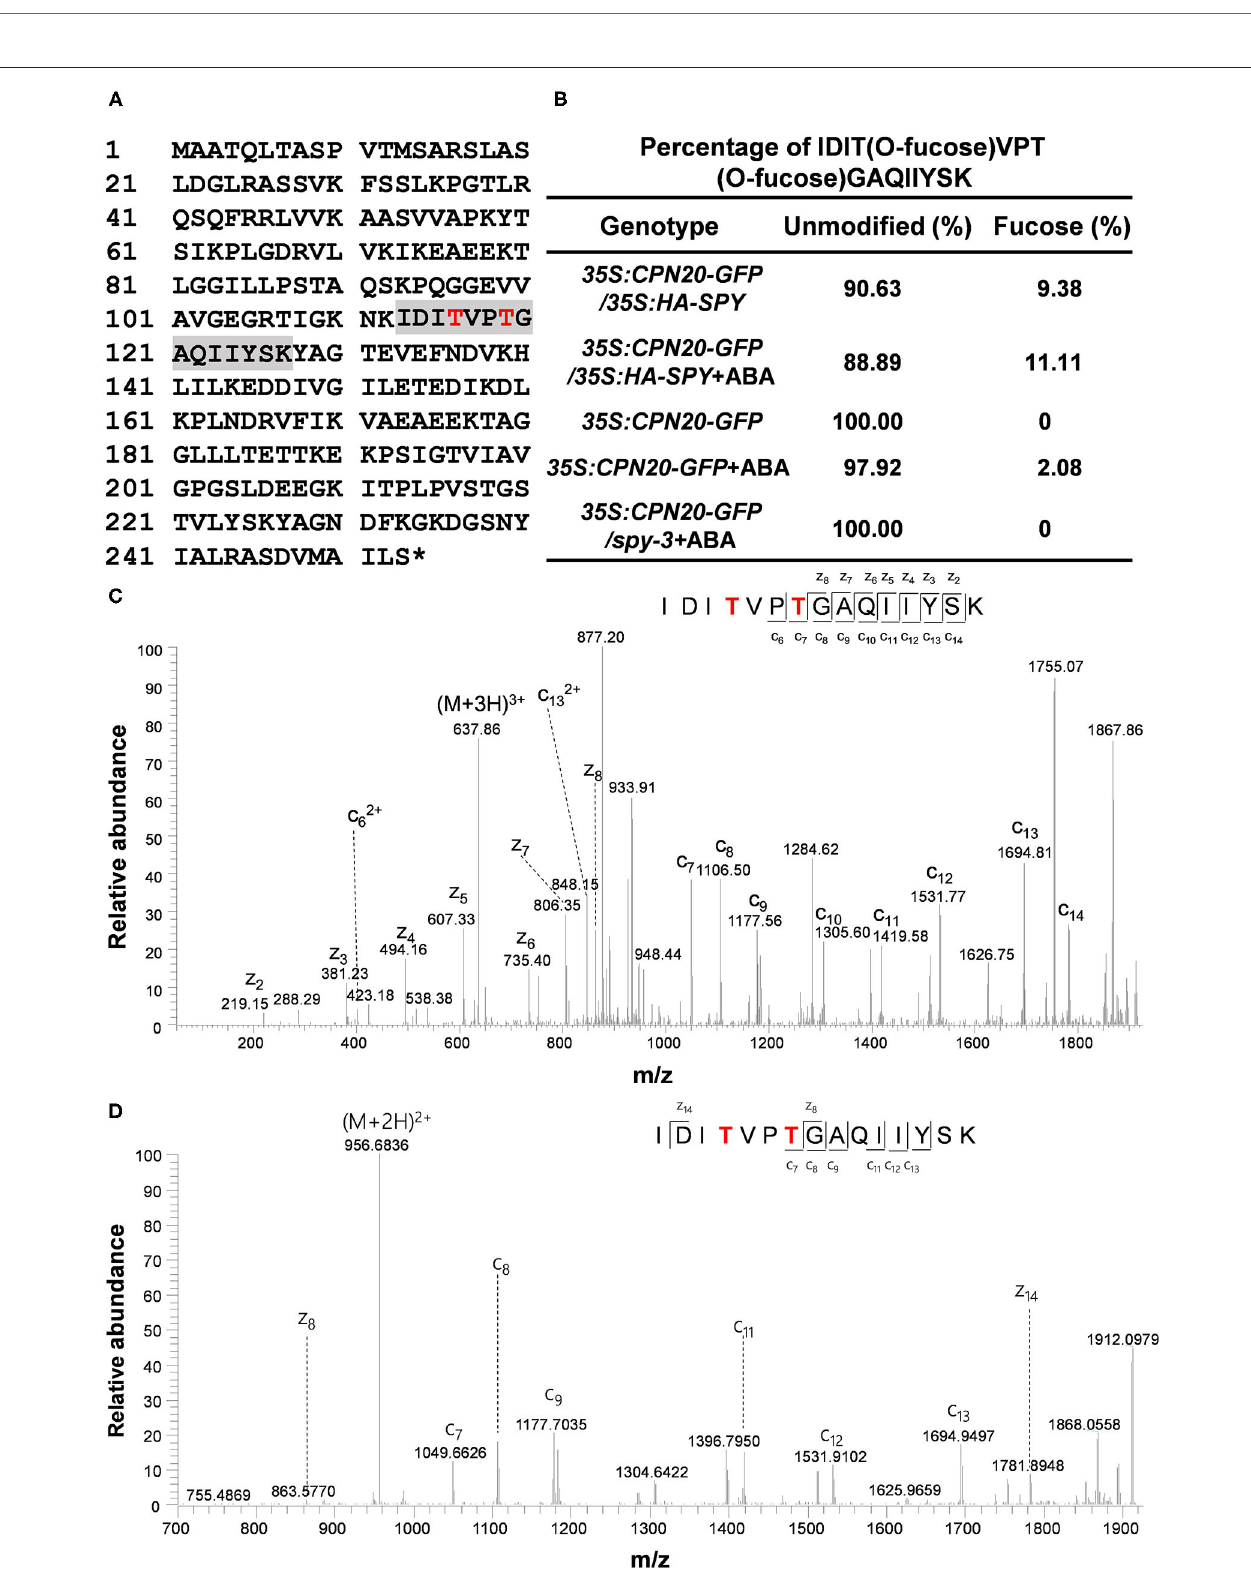
FIGURE 2 | CPN20 is O -fucosylated in mammalian cells and in planta . (A) O -fucosylation sites in CPN20 determined by ETD-MS/MS. A sequence in gray is an O -fucose modified peptide within CPN20 isolated from germinating seeds of CPN20-GFP / 35S:HA-SPY . Red letters indicate confirmed O -fucosylating sites.